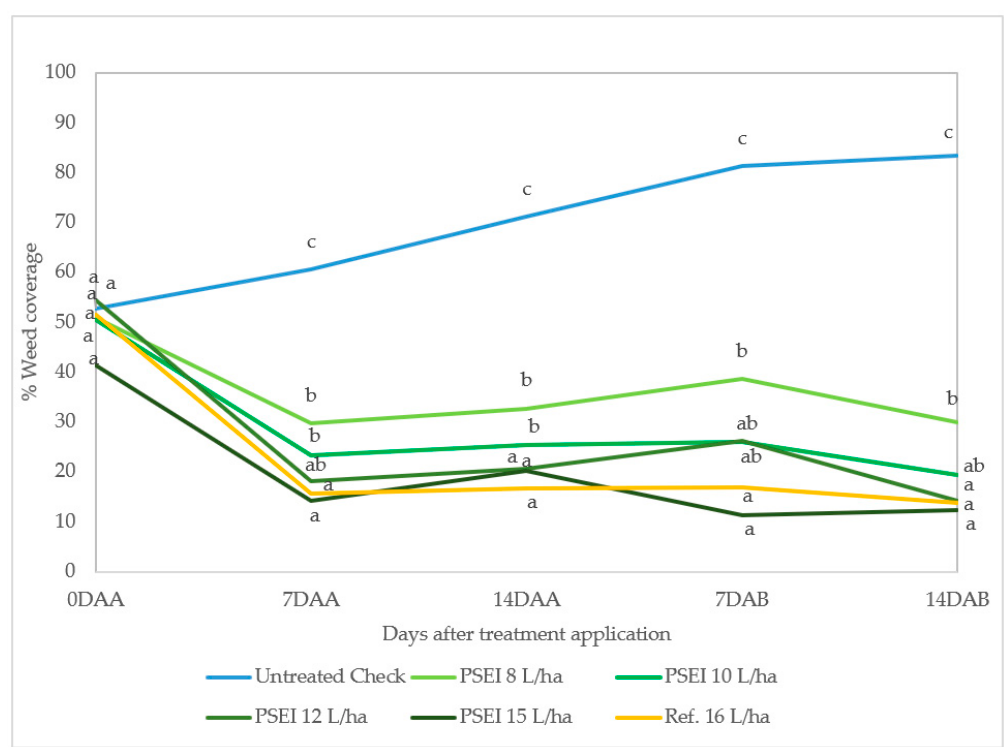
Figure 4. Global coverage percentage (monocots + dicots) of weed coverage in seven trials after two applications of PA formulation, PSEI, at different doses of 8, 10, 12, and 15 L/ha (4400, 5500, 6600, and 8250 g of a.s. per ha, respectively) compared to PA reference of PA at 16 L/ha (10,880 g of a.s. per ha). Assessment of weed coverage was made 7 and 14 days after the first application (A), and 7 and 14 days after the second application. A total of seven trials were established in different locations of Spain and Italy over 2020–2021 in vineyard fields. Different letters in the same assessment date point indicate significant differences ( p < 0.05) between treatments.